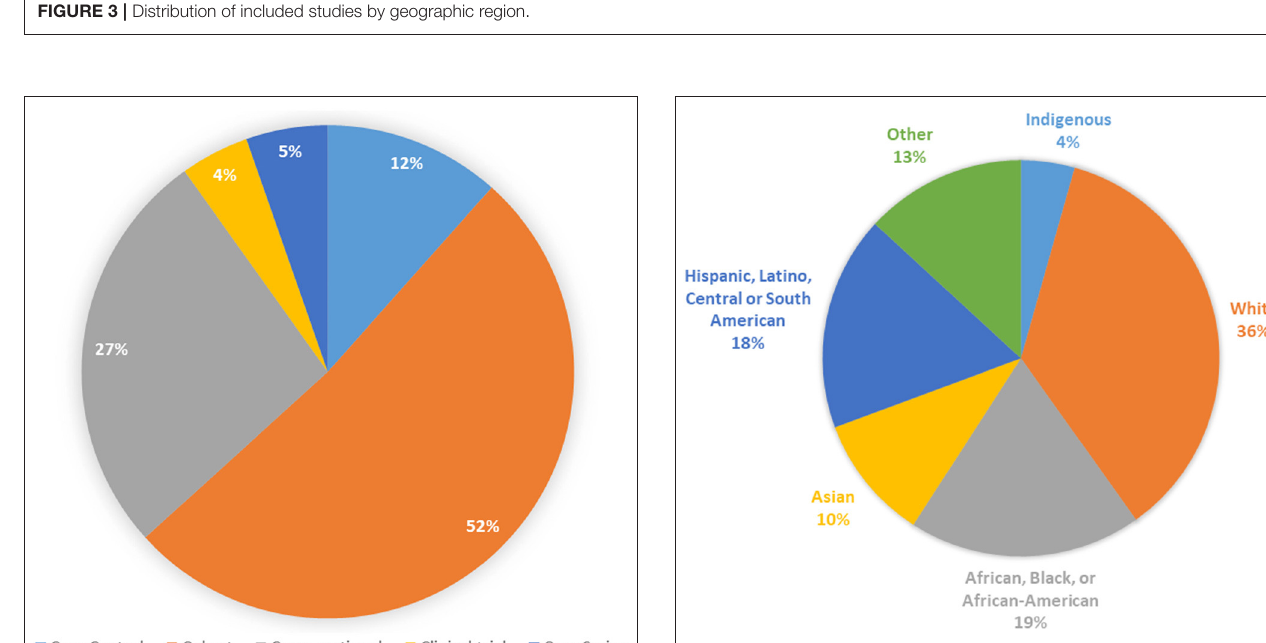
FIGURE 5 | Racial and ethnic categories reported by study where reported ( n = 45 studies).